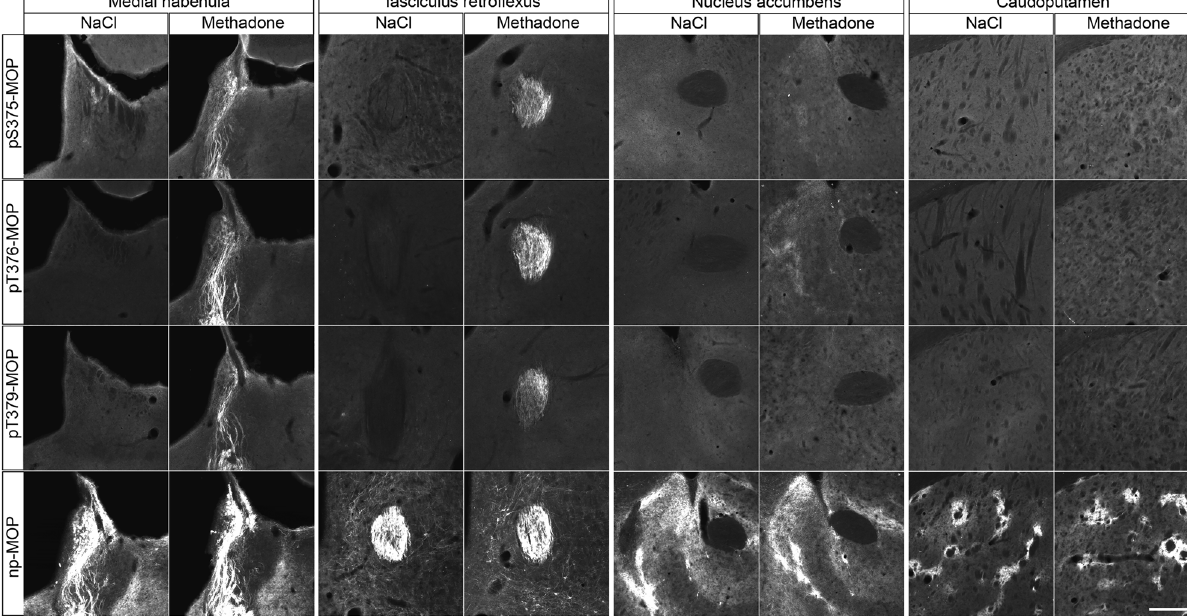
Fig. 7 Agonist-induced phospho-MOP immunostaining in mouse brain. Animals were treated with methadone for 30 min, transcardially perfused, fi xed and stained in the presence of PPIs. Shown are confocal images of coronal brain sections stained with phosphosite-speci fi c antibodies pS375-MOP, pT376- MOP or pT379-MOP or phosphorylation independent np-MOP antibody. Note that all three phosphosite-speci fi c antibodies detected agonist-induced MOP phosphorylation in the medial habenula and fasciculus retro fl exus but not in nucleus accumbens or caudate putamen, brain regions known to be rich in MOP receptors as shown by np-MOP antibody staining. Scale bar = 250 µ m. COMMUNICATIONS BIOLOGY| (2023) 6:419